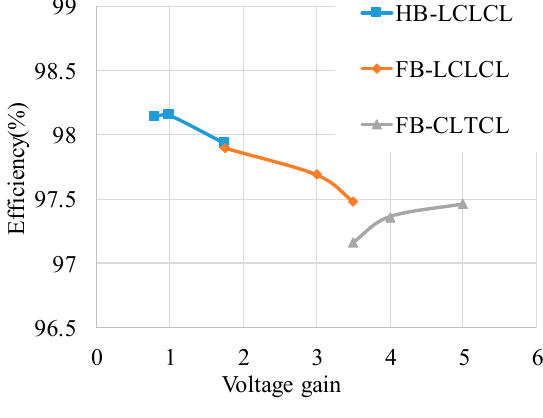
Figure 19. Efficiency curve.